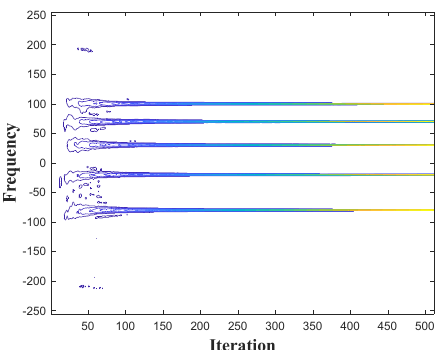
Figure 4. The main component estimation results.